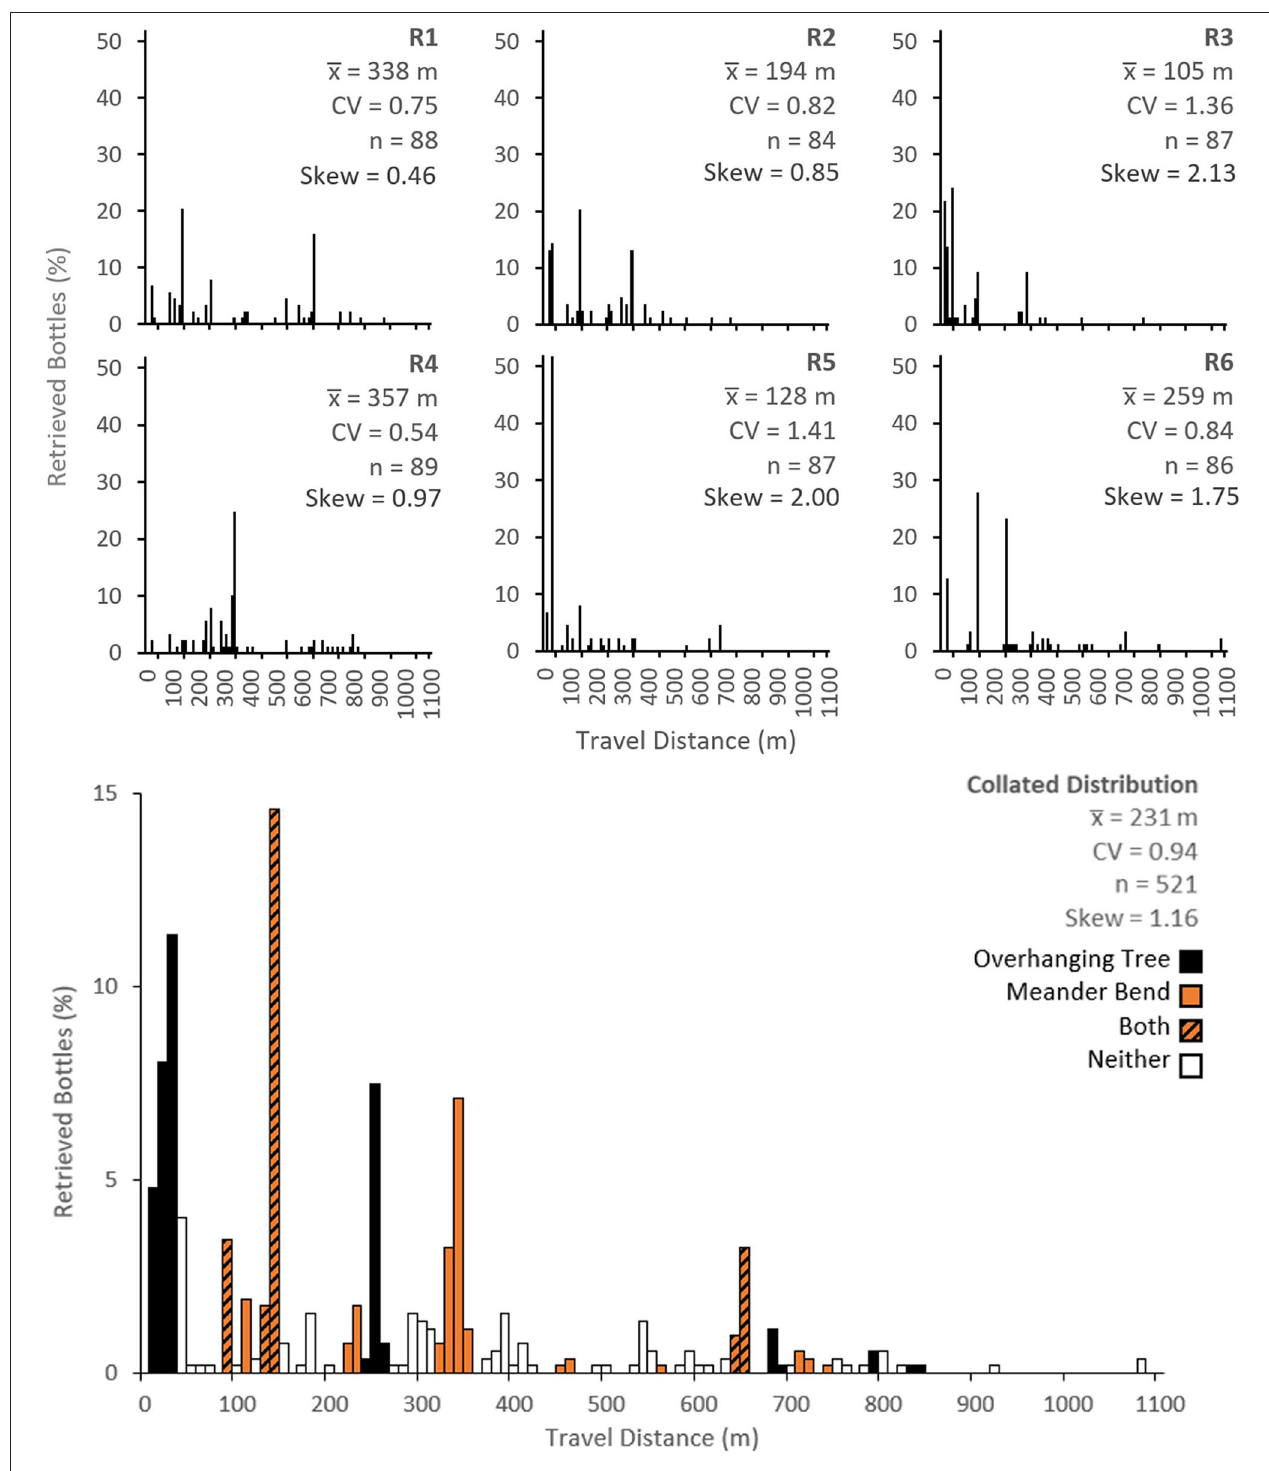
FIGURE 3 | Observed plastic bottle travel distance distributions from the six replicate experiments (R1–R6) in the top panels and the combined data (bottom panel). The combined data is colour-coded according to the presence or absence of overhanging tree and meander bend traps. x , mean travel distance; CV, coefficient of variation; n, number of bottles